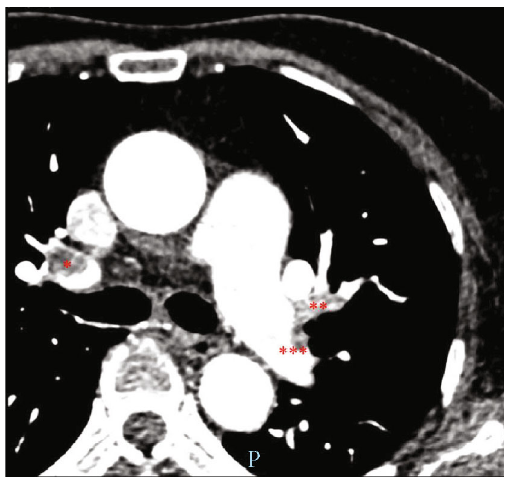
Figure 1: The spiral computed tomography angiogram obtained with highly concentrated contrast material and high fl ow technique showed multiple pulmonary emboli that subtotally occluded the right upper lobar pulmonary artery ( ∗ ) and the left lingular artery ( ∗∗ ). The left lower lobar pulmonary artery was also partially occluded ( ∗∗∗